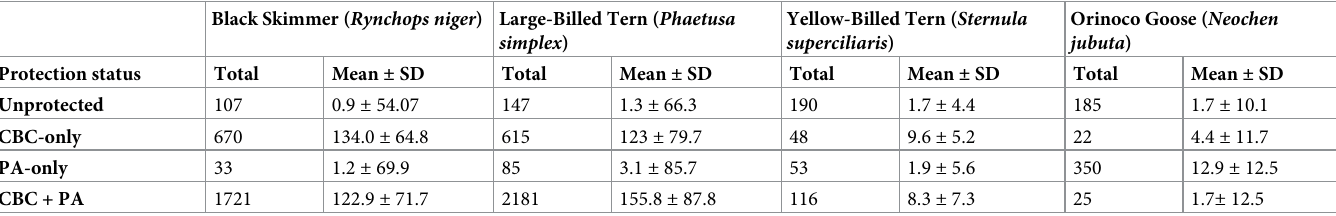
Table 1. Total and mean ( ± standard deviation) number of individuals for four waterbird species surveyed along the Jurua´ River, Amazonas, Brazil. Black Skimmer ( Rynchops niger ) Large-Billed Tern ( Phaetusa Yellow-Billed Tern ( Sternula Orinoco Goose ( Neochen simplex ) jubuta